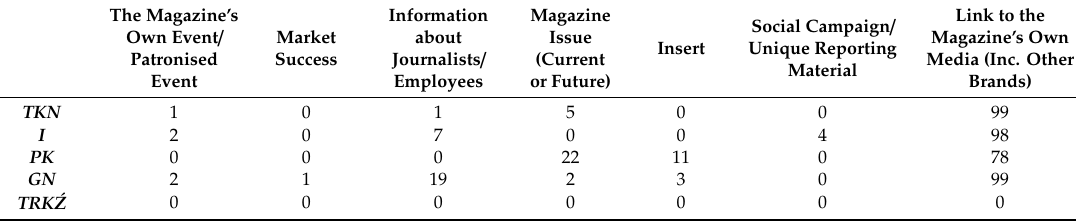
Table 12. Primary and secondary self-promotional categories